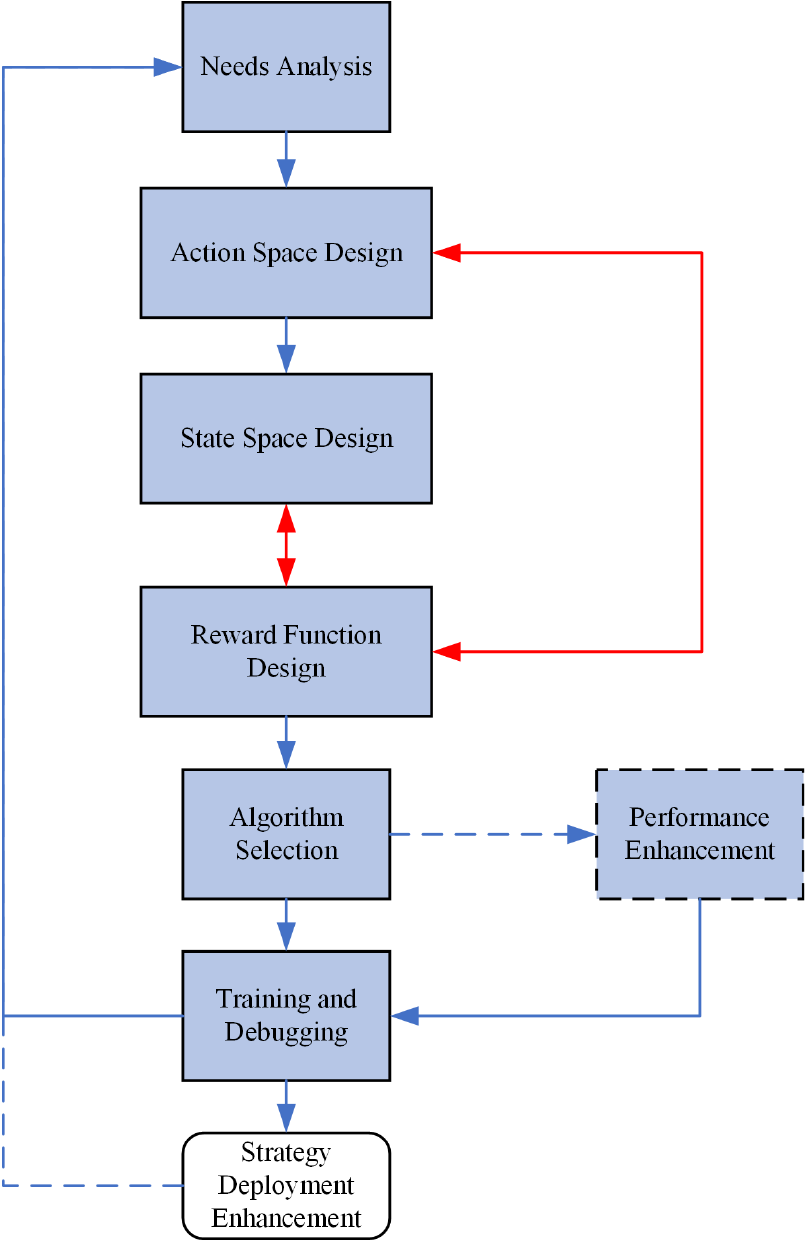
Figure 1. DRL algorithm landing process.